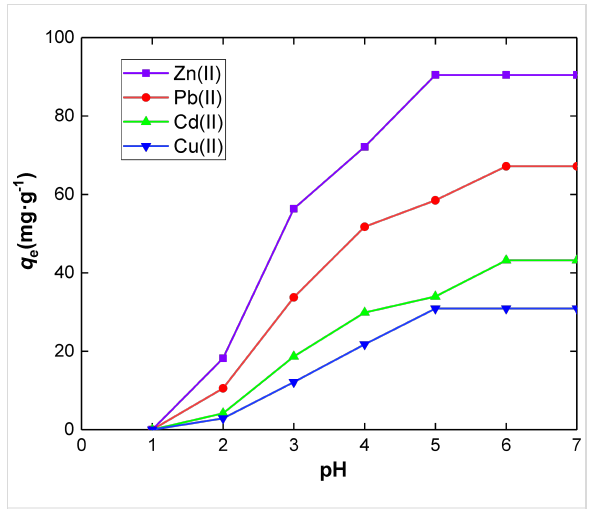
Figure 5: Effect of pH on the adsorption of metal ions on SiNL, Adsorption dose: V = 10 mL, m = 10 mg of SiNL at optimum concen- tration (100 ppm in each case), t = 35 min and 25 °C, ∆ q e = 0.3 (mg·g − 1 ). (The optimum concentration means the initial con- centration of metal ions required to reach a plateau shape).